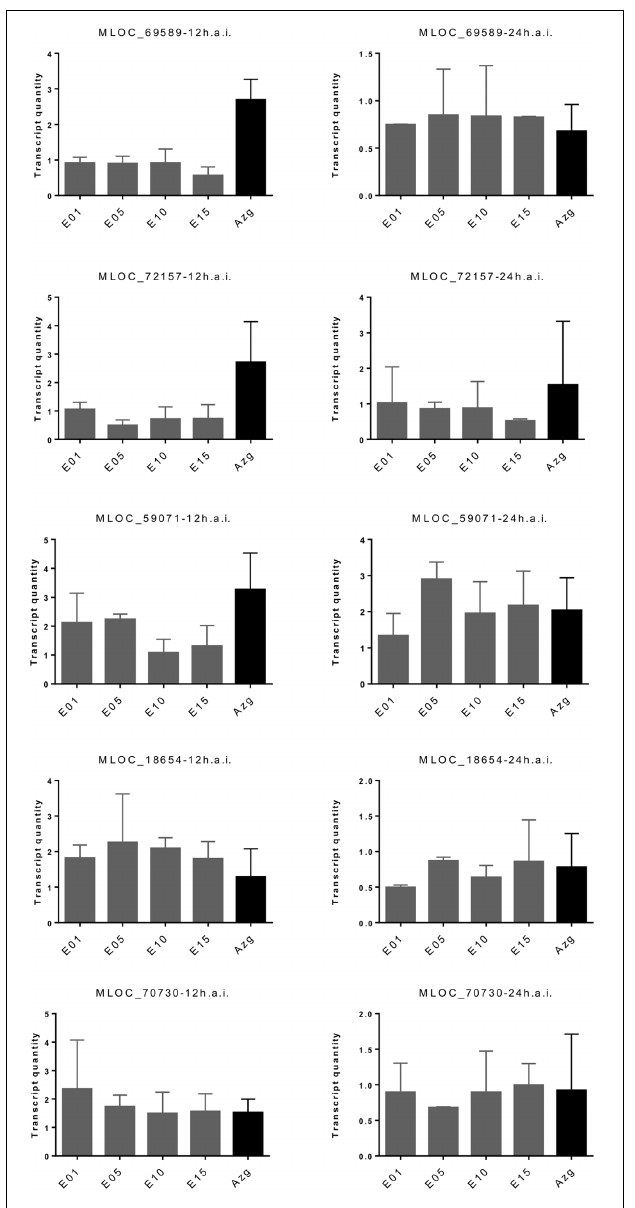
FIGURE 5 | Redued induction of proposed PTI marker genes in HvLEMK1 -silenced barley plants. Wildtype plants or selected transgenic T1 families were inoculated with Bgt , followed by RNA extraction 12 and 24 h after inoculation and quantification of transcript amounts by RT-qPCR. Mean values ± SE from two independent experiments (batches of plants sown on different dates) using a total of 10–14 transgenic plants are shown. Proposed protein functions: MLOC_69589, PR17-like secreted protein; MLOC_72157, SERK1-like RLK; MLOC_59071, putative leucoanthocyanidin dioxygenase; MLOC_18654, hypothetical protein; MLOC_70730, caffeoyl-CoA- O -methyltransferase.